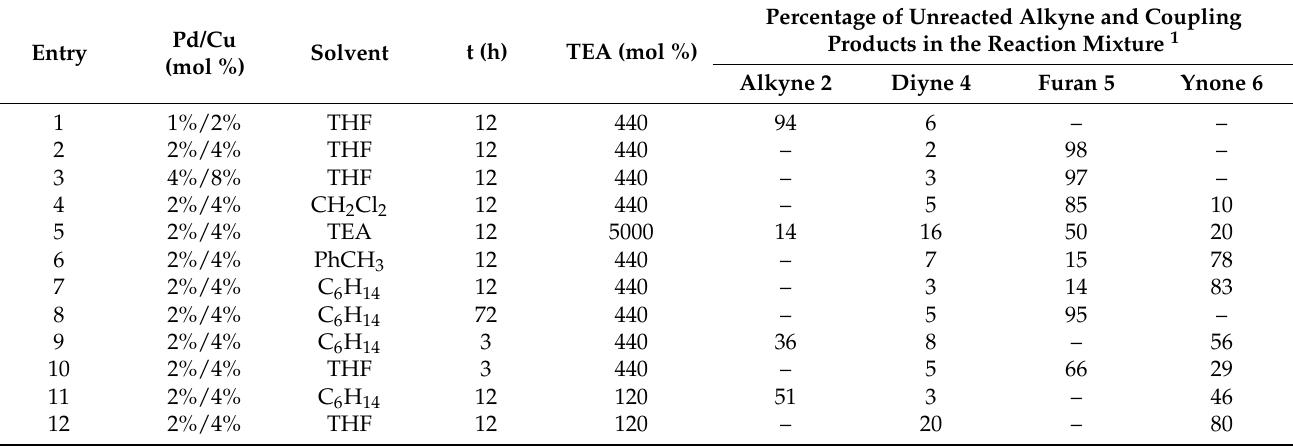
Table 1. Optimization of the cross-coupling of propargyl ether 2 with PhC(O)Cl.